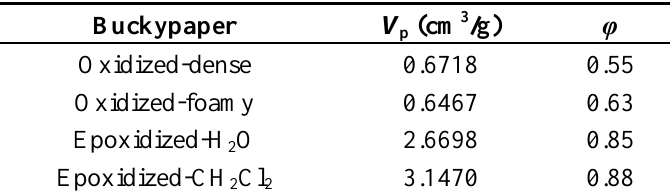
Table 1. Data from porosimetry experiments. V material and  is the %